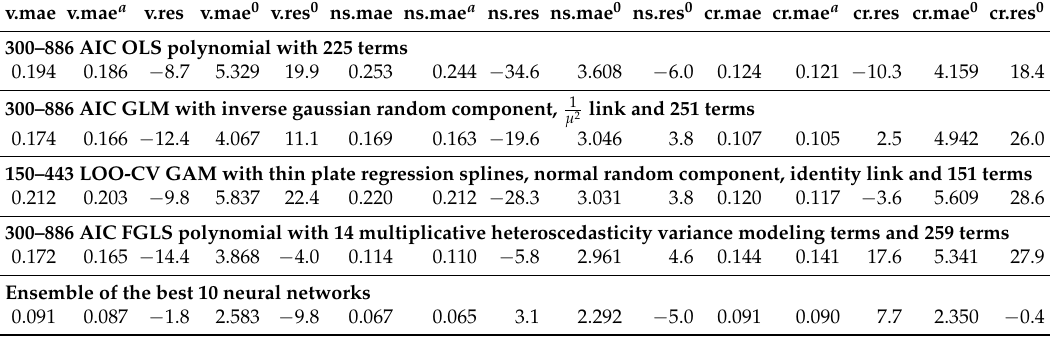
Table 3. Validation figures for the best OLS and FGLS polynomials, GLM and GAM derived in Krah et al. (2020), and the ensemble of 10 best performing neural networks after the exclusion of the points with scenarios outside of the fitting space. MAEs in